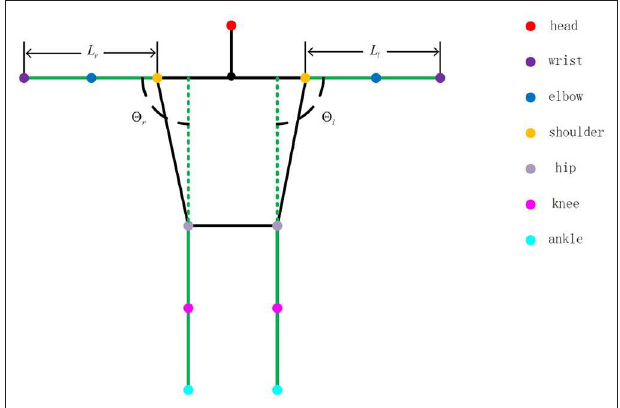
TABLE 1 | Meanings of different coefficient combinations. Combination Meaning Interaction initiation 100 < 2 l < 150 and L r < L l Flight direction command 1: right front with respect to the human 30 < 2 l < 80 and L r < L l Flight direction command 2: right rear with respect to the human 100 < 2 r < 150 and L l < L r Flight direction command 3: left front with respect to the human 30 < 2 r < 80 and L l < L r Flight direction command 4: left rear with respect to the human 100 < 2 l < 180 and Flight distance command: based on 100 < 2 r < 180 positions of two wrist joints 0 < 2 l < 30 and 0 < 2 r < 30 End flag